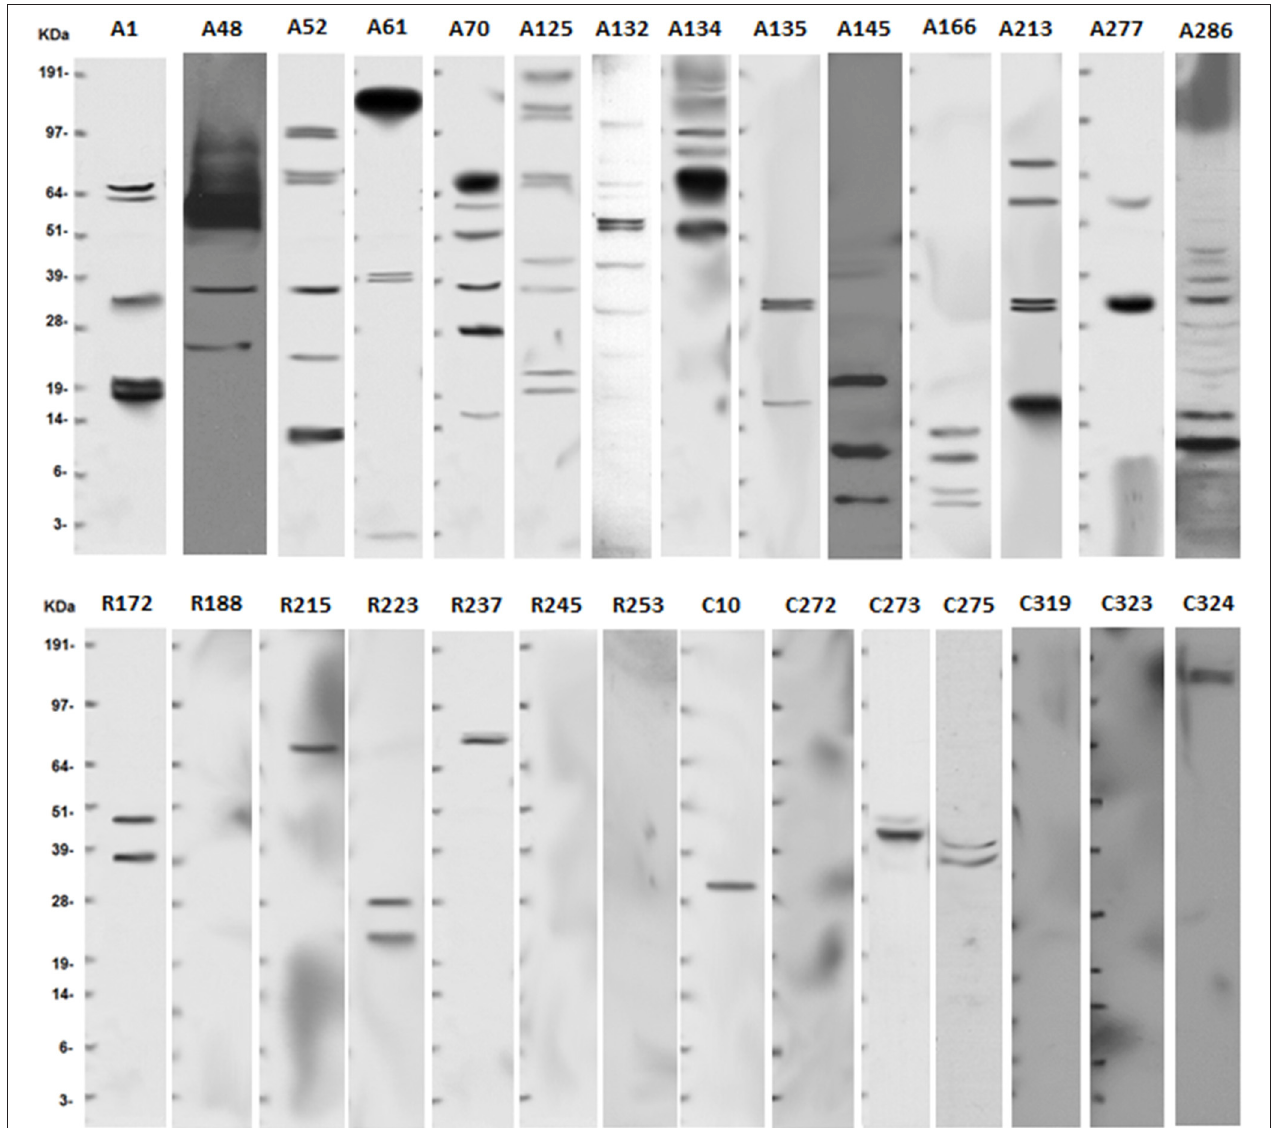
FIGURE 1 | Anti-retinal antibodies are more common in serum of AIR patients than in non-autoimmune RP patients or controls. Serum was collected from newly diagnosed and untreated AIR (A#) patients, RP (R#) patients, or healthy control (C#) individuals. Human retinas were isolated from cadaver eyes provided by the Michigan Eye Bank/Eversight. Retinal proteins were prepared by homogenization and 30 µ g of protein was separated on a 10% NuPAGE gel by using standard electrophoresis methods. Proteins were transferred to a nitrocellulose membrane that was used to capture anti-retinal antibodies from a 1:100 dilution of patient serum. Binding was detected using biotinylated anti-human IgG antibody, horseradish peroxidase-conjugated streptavidin, and SuperSignal West Pico Chemiluminescent Substrate. Exposure to auto-radiography film was for 10 minutes, and SeeBlue Plus 2 molecular weight standard was run on each gel to align protein sizes. Representative blots are shown for RP patients and controls, but all individuals were tested.